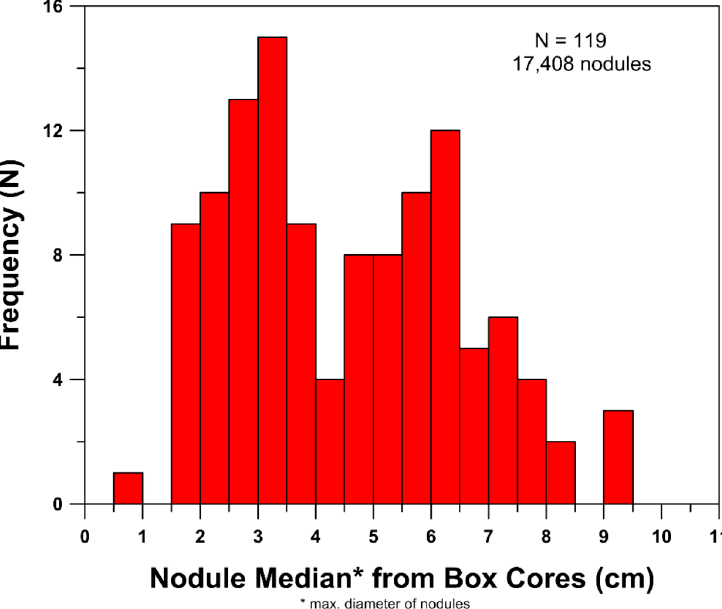
Figure 11. Distribution of mean nodule size (longest axis) measured for 17,408 nodules from 119 box cores, of which about half come from areas with large nodules and the other half from areas with small nodules. The bimodal distribution indicates that nodule size is not equally distributed over the entire size range.